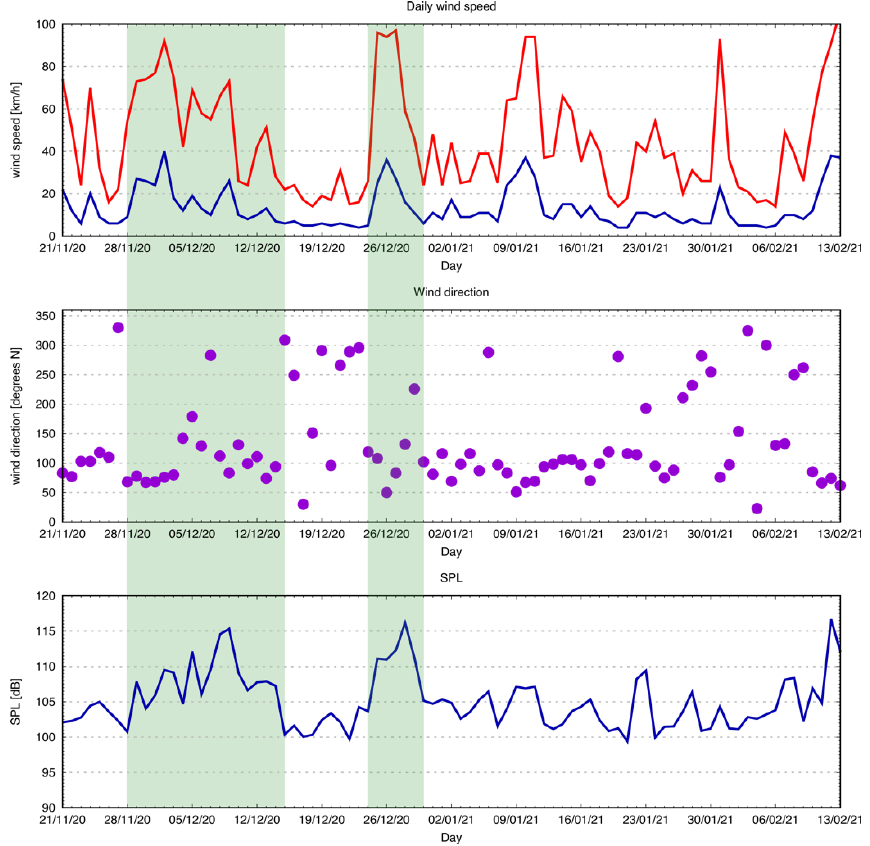
Figure 16. Time series correlation of wind and SPL. Some periods seem to be correlated (green areas), while not all periods of strong wind result in increased SPL.